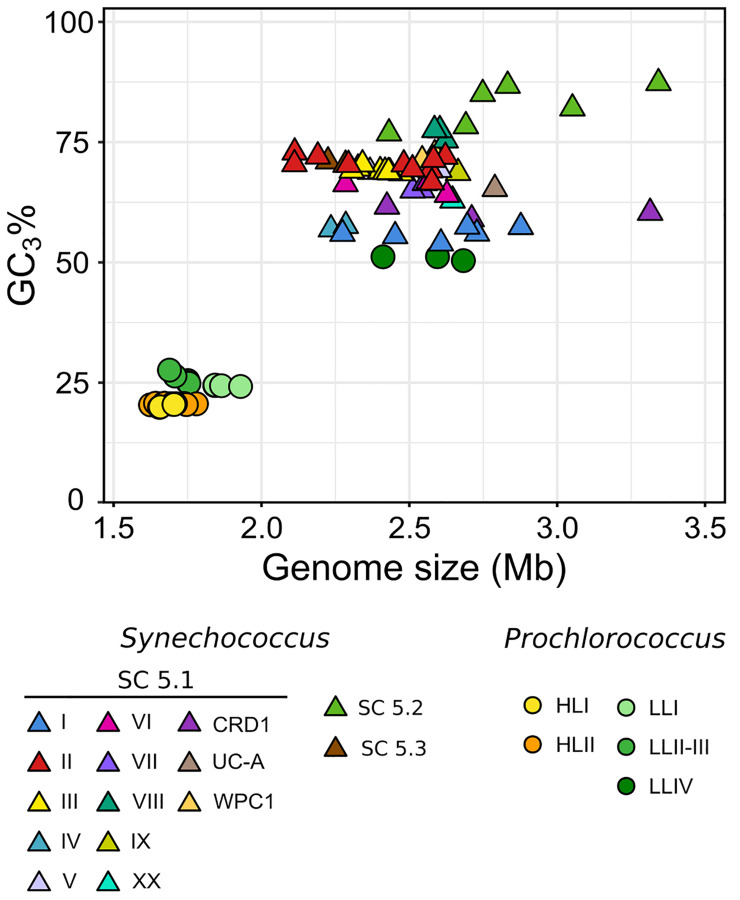
Relationship between genome size and GC3% (GC content at the third codon position). Each symbol corresponds to a different genome, with Prochlorococcus indicated by circles and Synechococcus/Cyanobium by triangles. The color of each symbol indicates the clade or SC.